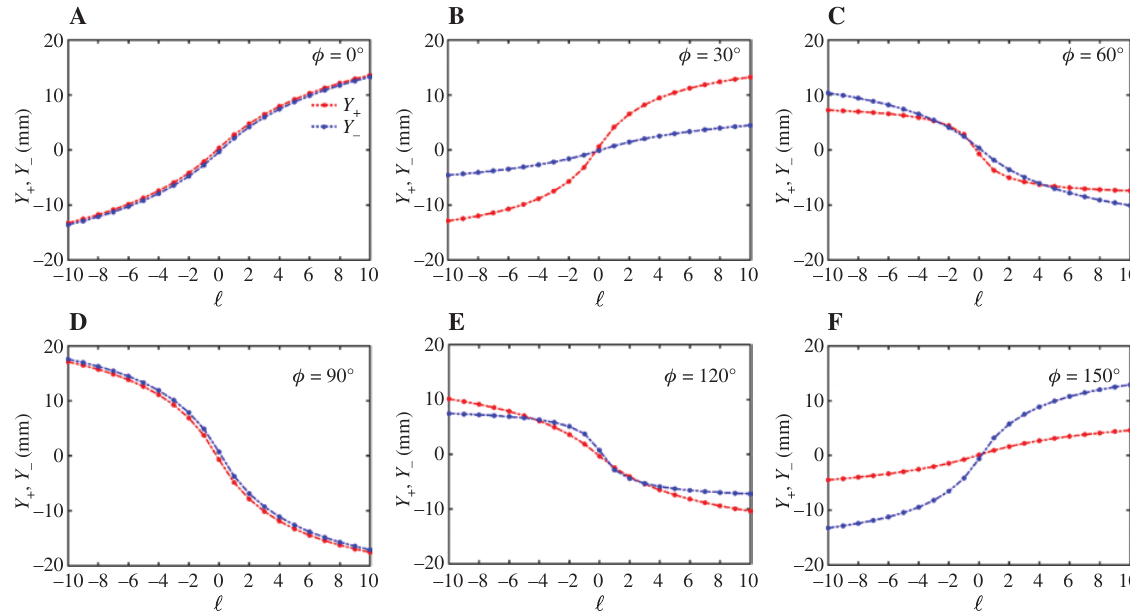
on the incident OAM ℓ for φ = 0 ° , 30 ° , 60 ° , 90 ° , 120 ° , 150 ° , ±